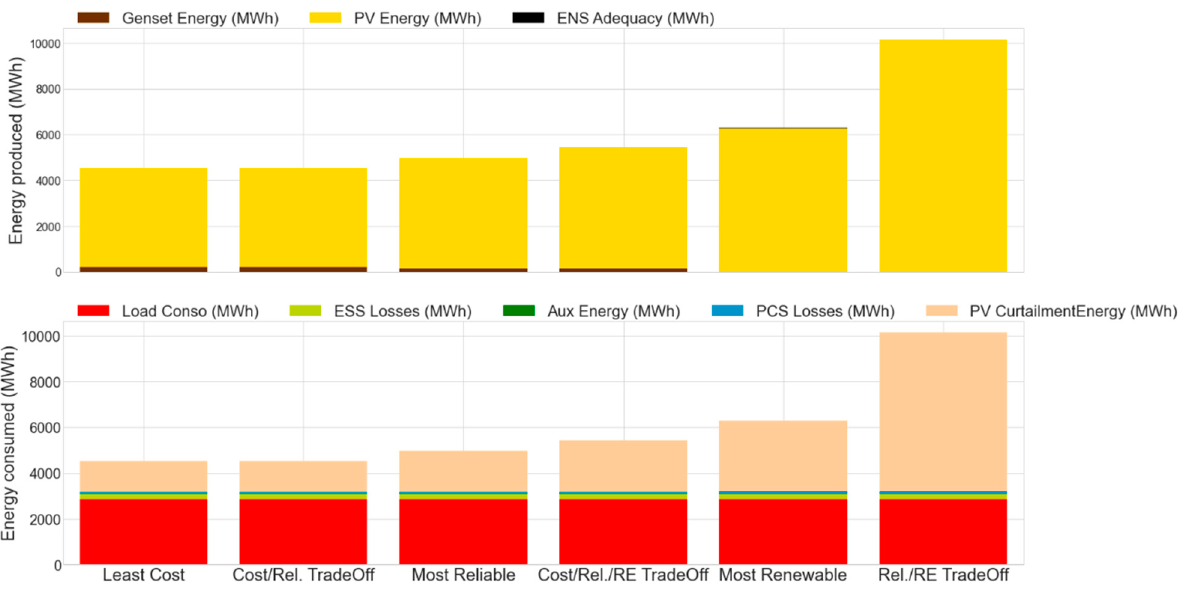
Figure 11. Energy flows for the six selected solutions.